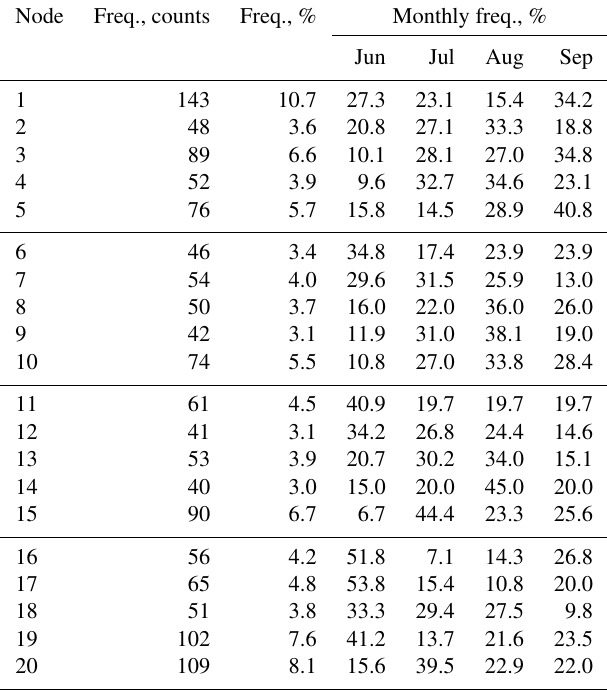
Table 1. Summary statistics for SOM node frequency. Total and monthly frequencies over the 11-year period are shown. Node Freq., counts Freq., % Monthly freq., %